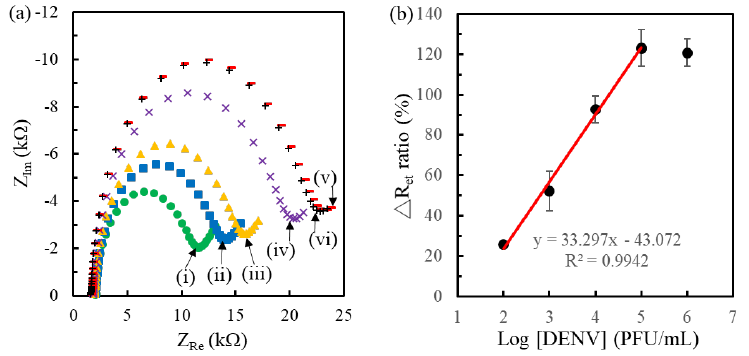
Figure 7. ( a ) Nyquist plots obtained at the pDNA / MHA(0.04 mM) / MCH(1 mM) / Au genosensors (i) followed by the 20 min hybridization of RNA fragments extracted from 10 2 (ii), 10 3 (iii), 10 4 (iv), 10 5 (v) and 10 6 (vi) PFU / mL DENV1. ( b ) The corresponding calibration curve of the genosensors ( n = 3).